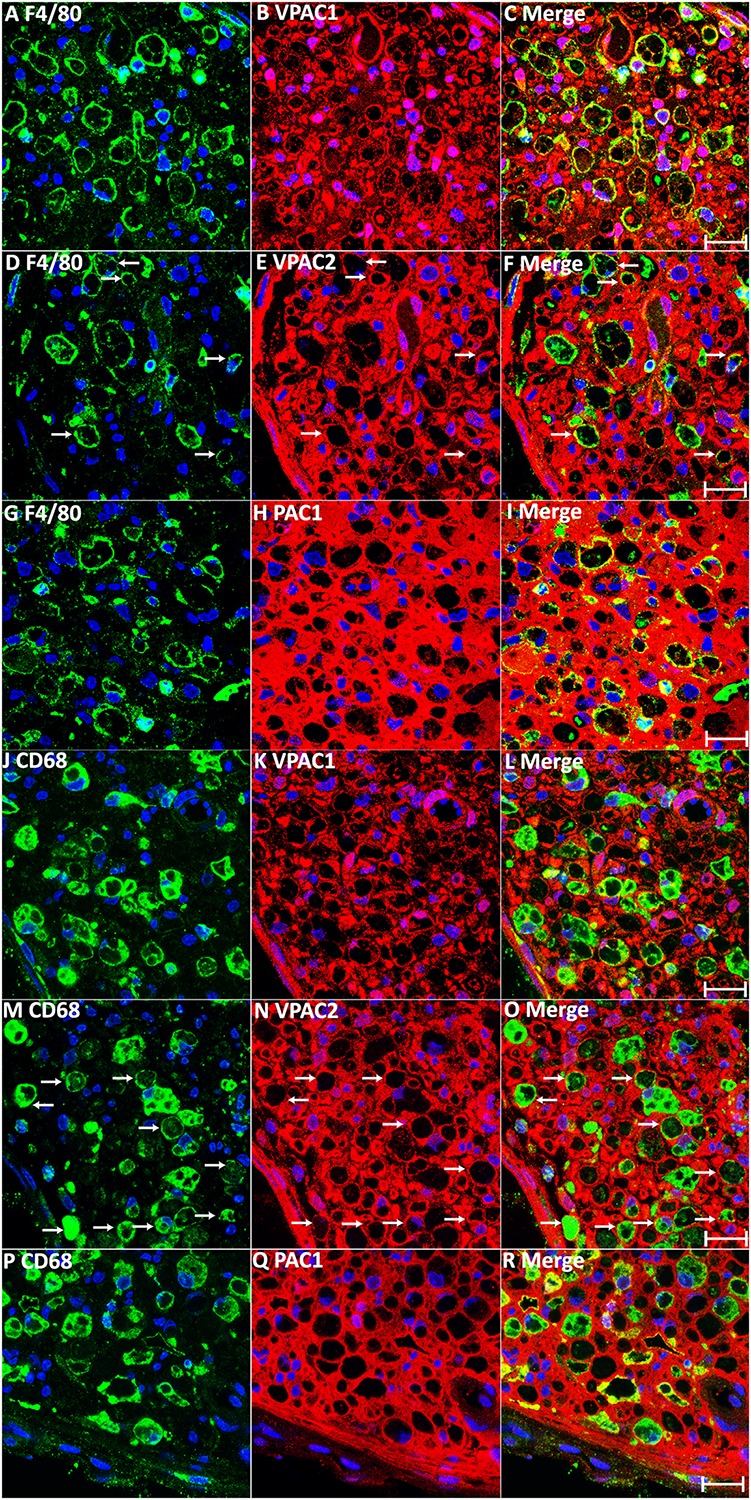
Expression of VPAC1, VPAC2, and PAC1 in macrophages of the mouse distal sciatic nerve at 7 days post-injury. (A–I) Double staining of VPAC1, VPAC2, and PAC1 with macrophage marker F4/80 on transverse sections from mouse distal sciatic nerve at 7 days post-transection injury. (J–R) Double staining of VPAC1, VPAC2, and PAC1 with macrophage marker CD68 on transverse sections from mouse distal sciatic nerve 7 days post-transection injury. VPAC1 (A–C,J–L) and PAC1 (G–I,P–R) are expressed in most macrophages of the distal nerve stump. Macrophages expressing VPAC2 are indicated by arrows in (D–F,M–O). Scale bars 20 μm. Three mice were used and three sections from each mouse were stained for each receptor.